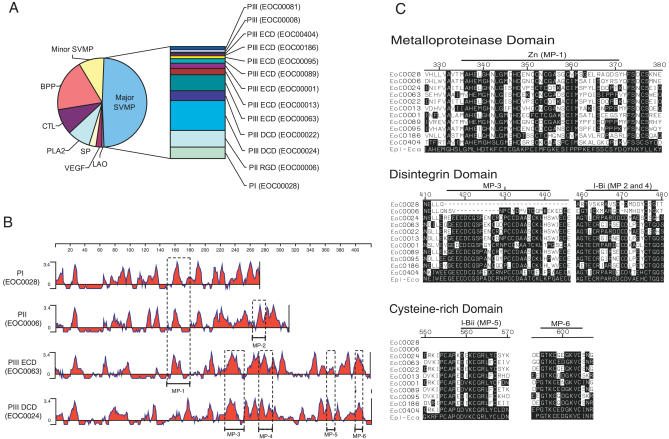
Identification of Conserved Domains in Snake Venom Metalloproteinases(A) Proportional representation of toxin-encoding transcripts. The proportional representation of SVMP clusters are expanded as a histogram and classified as PI–PIII isoforms. Identifiers for each cluster are indicated in parentheses. Minor SVMPs denote transcripts represented as singletons or smaller SVMP clusters (four ESTs or fewer) whose isoform class could not be reliably identified. BPP, bradykinin-potentiating peptides; CTL, C-type lectin; LAO, L-amino oxidases; PLA
2, group II phospholipase A
2; SP, serine proteinases; SVMP, snake venom metalloproteinases; VEGF, vascular endothelial growth factors.
(B) Comparative Jameson-Wolf antigenic profiling of representatives of the PI (EOC00028), PII (EOC00006), PIII ECD motif (EOC00063), and PIII DCD motif (EOC00024). The propeptide domain, which is proteolytically released from the zymogen [
9], is excluded. Antigenic domains that show the greatest levels of sequence conservation are indicated below each transcript (MP 1–6).
(C) Sequence alignment of
E. ocellatus venom gland SVMP isoforms. The alignments are truncated and separated into three SVMP functional domains annotated with antigenic domains (EoMP 1–6) and motifs of functional or catalytic significance. Residues identical to ecarin (Epl–Eca [Q90495]) are shown in black for comparison. Full-length alignments are provided in
Figure S1. I-Bi, integrin-targeting tripeptide motifs; I-Bii α
2β
1 integrin-binding VKC-like motifs in jararhagin-C [
46]; Zn, catalytic zinc-binding motif.